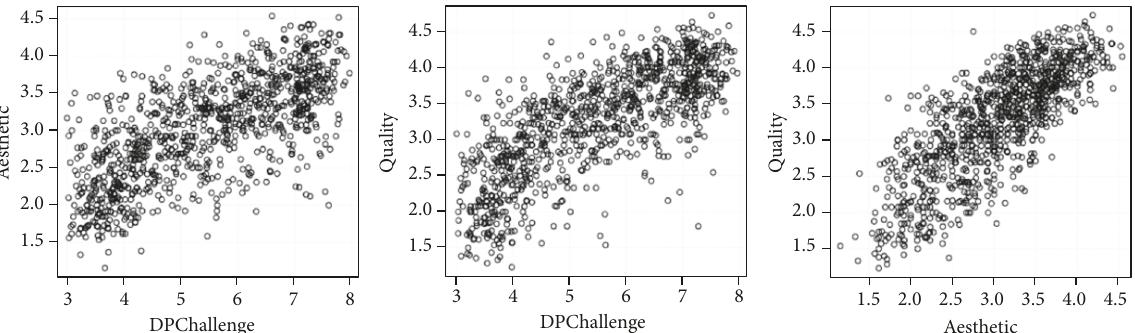
Figure 4: Scatterplots between ranks for the three possible combinations given the criteria evaluated for the entire